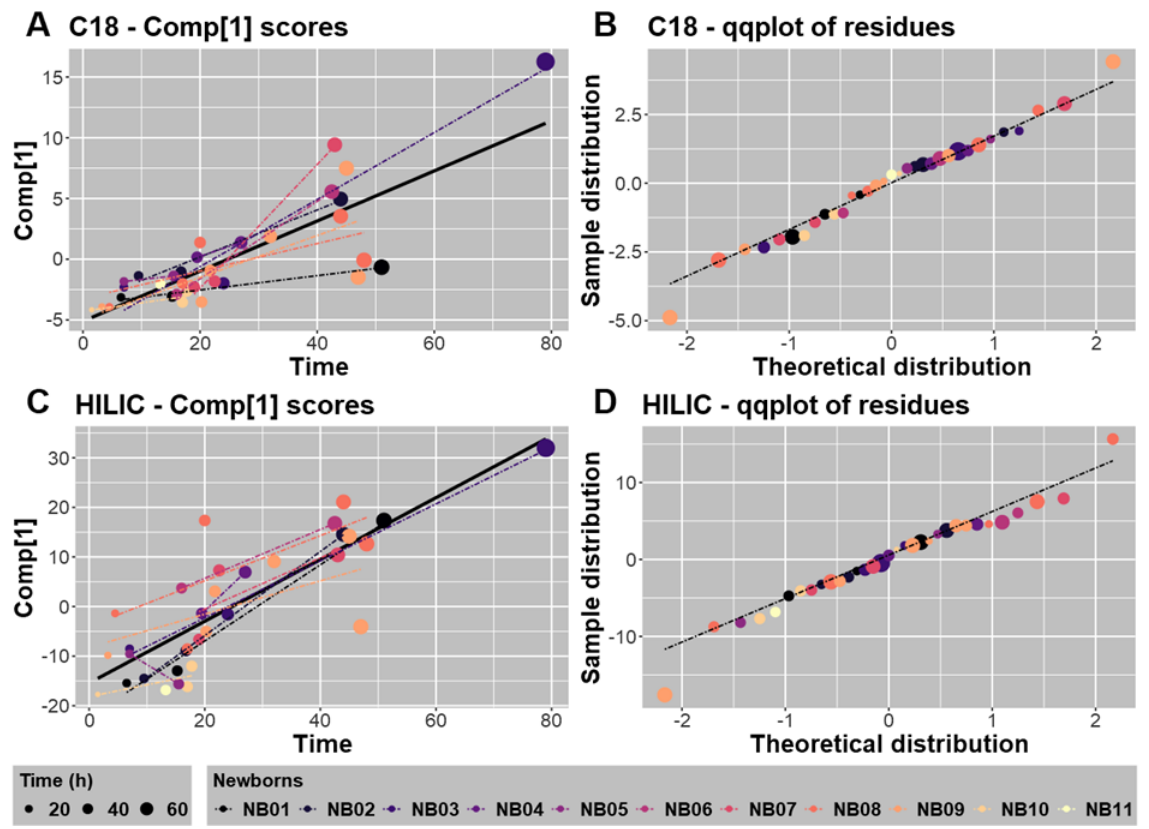
Figure 5. Modeling of the variation in the Comp[1] scores with time (h) for the C18-ESI + ( A ) or HILIC-ESI − ( C ) analytical conditions. Comp[1] scores were calculated according to a sPLS regression between the metabolomic datasets and the time at which fecal matrices were collected. The global regressions were drawn according to the thick continuous black line. For every newborn, a mixed model linear regression was applied to model the regression between Comp[1] scores and time and individual regressions are plotted as dashed lines. The distributions of residues calculated after regression were compared to the theoretical one for metabolites detected under the C18-ESI + ( B ) or HILIC-ESI − ( D ) analytical conditions. The Comp[1] scores were weakly predicted by the mixed model linear regression only for 1 or 2 samples from NB09, both collected after 40 h, in the C18-ESI + ( B ) or HILIC-ESI - ( D ) analytical conditions, respectively.